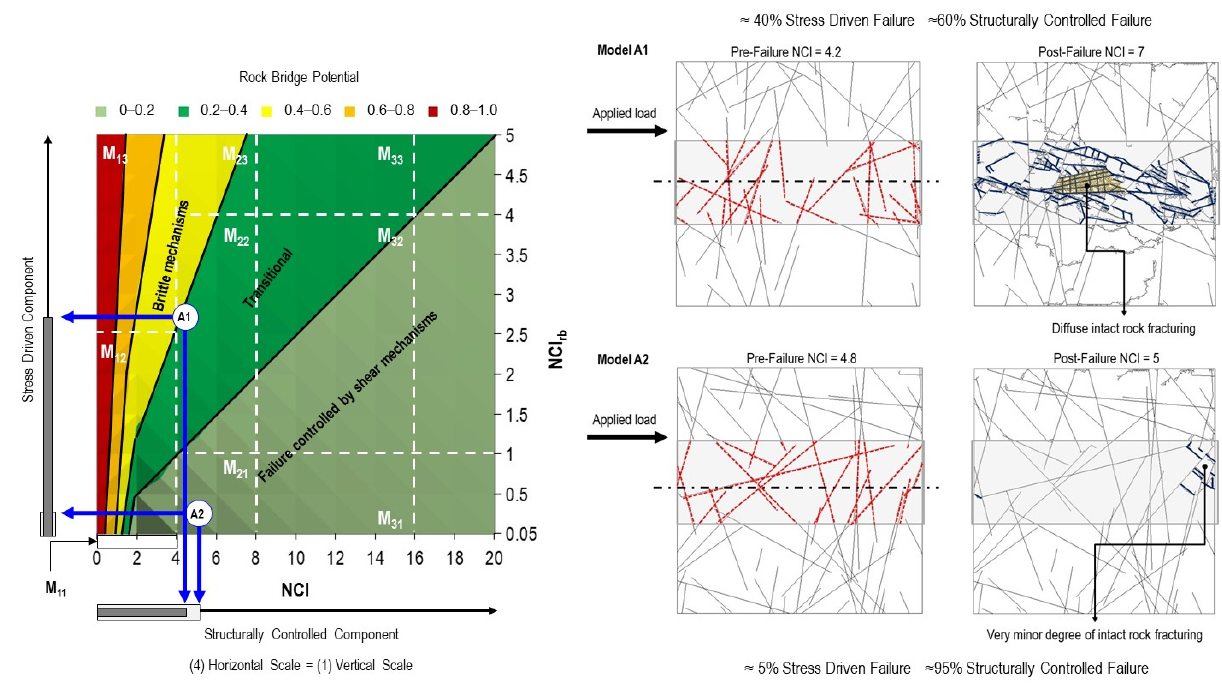
Figure 10. Example of using the concept of rock bridge potential to characterise the rock mass be ‐ haviour, defined by the proportional contribution of stress ‐ driven failure (represented by NCIrb) and structurally controlled failure (represented by NCI). Direct shear tests models from [23]. Percentages of rock mass behaviour are determined using the relative lengths across the horizontal and vertical scale (corrected for scale).